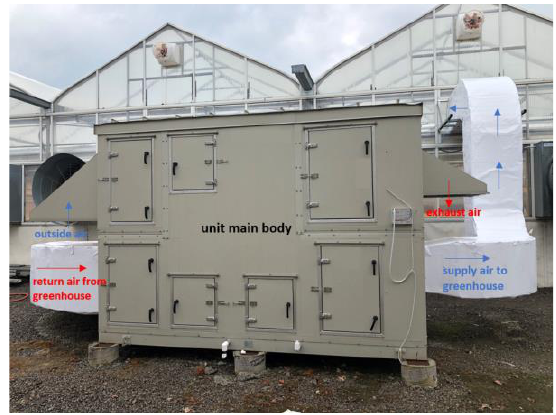
Figure A5. HRV used in study.